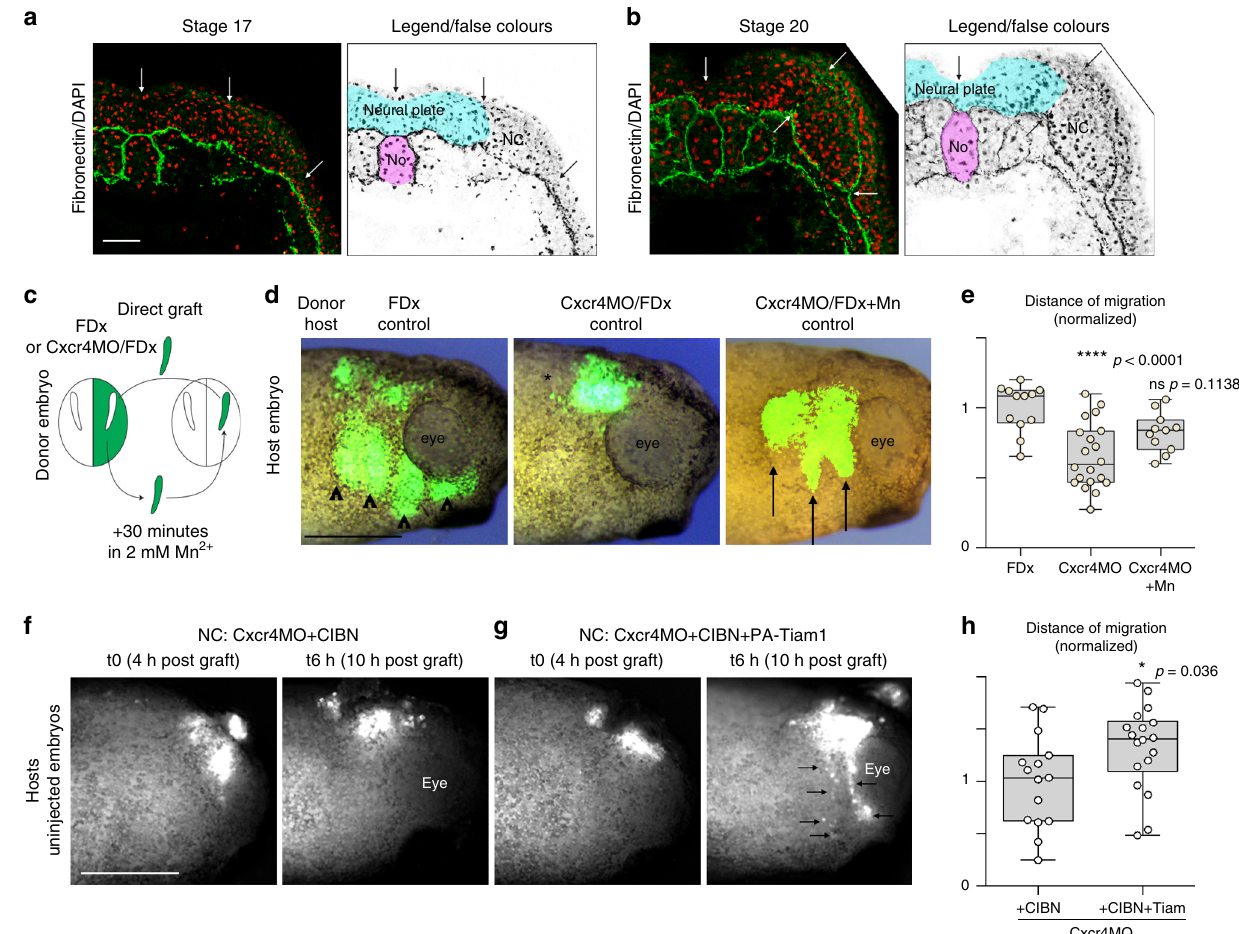
Fig. 9 Global activation of adhesion in vivo is suf fi cient to rescue Cxcr4 loss-of-function. a , b Fibronectin immunostaining on cryosections through the cephalic region of St17 ( a ) and St20 ( b ) Xenopus laevis embryos. c Diagram depicting the grafting procedure. d Representative images of the three types of grafts that were performed. Controls NC cells (FDx), cells injected with Cxcr4MO with or without prior exposure to Mn 2 + were grafted into control non- injected hosts embryos. e Normalised net distance of migration along the dorso-ventral axis of grafted cells after an overnight incubation following the graft, n = 43 grafted embryos from four independent experiments. ANOVA followed by multiple comparisons, p values are indicated on the graph. f Still images from time-lapse movies for Cxcr4MO cells co-injected with CIBN-GFP grafted into control embryos. g Still images from time-lapse movies for Cxcr4MO cells co-injected with CIBN-GFP and photoactivatable Tiam1 grafted into control embryos. Arrows indicate NC cells migrating along the dorso- ventral axis. h Normalised net distance of migration along the dorso-ventral axis of grafted cells after 6 h of time-lapse imaging, n = 33 grafted embryos from fi ve independent experiments. Student ’ s t -test, two tailed, p value indicated on the graph. FDx, fl uorescein dextran; NC, neural crest; No, notochord. Scale bar in a , 50 μ . Scale bars in d and f , 500 μ . Box and whiskers plot: the box extends from the 25th to the 75th percentile; the whiskers show the extent of the whole dataset. The median is plotted as a line inside the box. Source data are provided as a Source Data fi